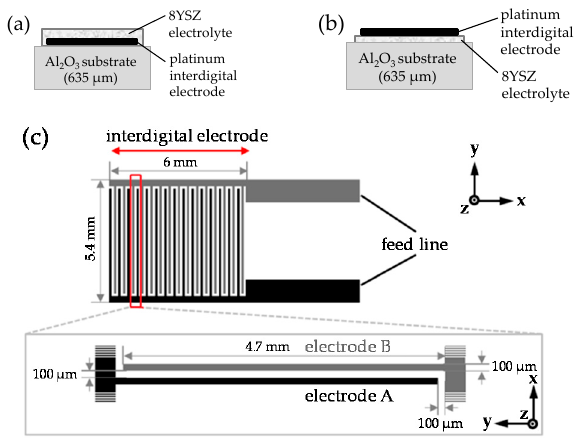
Figure 1. Schematic layouts for the pulsed polarization technique to detect NO x : cross-sectional depiction with the platinum interdigital electrode ( a ) buried between the alumina substrate and the 8YSZ electrolyte, and ( b ) overlying above the 8YSZ electrolyte. ( c ) Geometry of the platinum interdigital electrode (top view) used for both layouts.